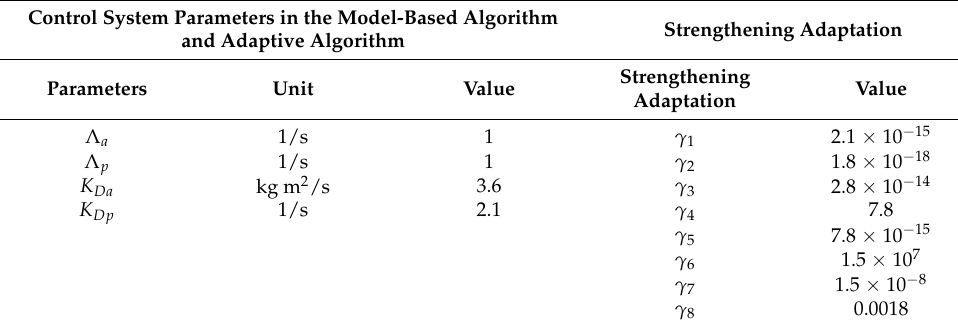
Table 3. Parameters of the model and of control systems used in experimental research.